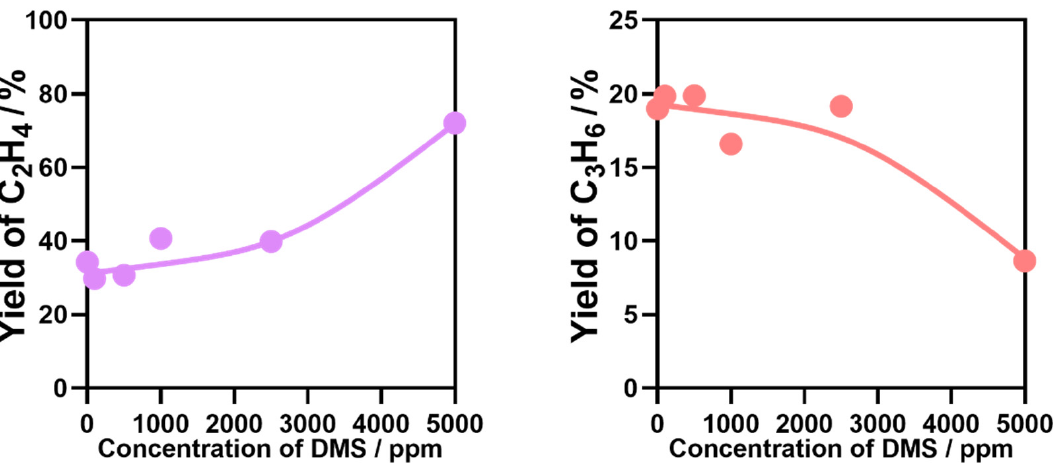
Figure 11. Effect of DMS content on ETO reactions. Temperature, 400 °C; W/F = 0.0025 g/cm 3 ·min − 1 .